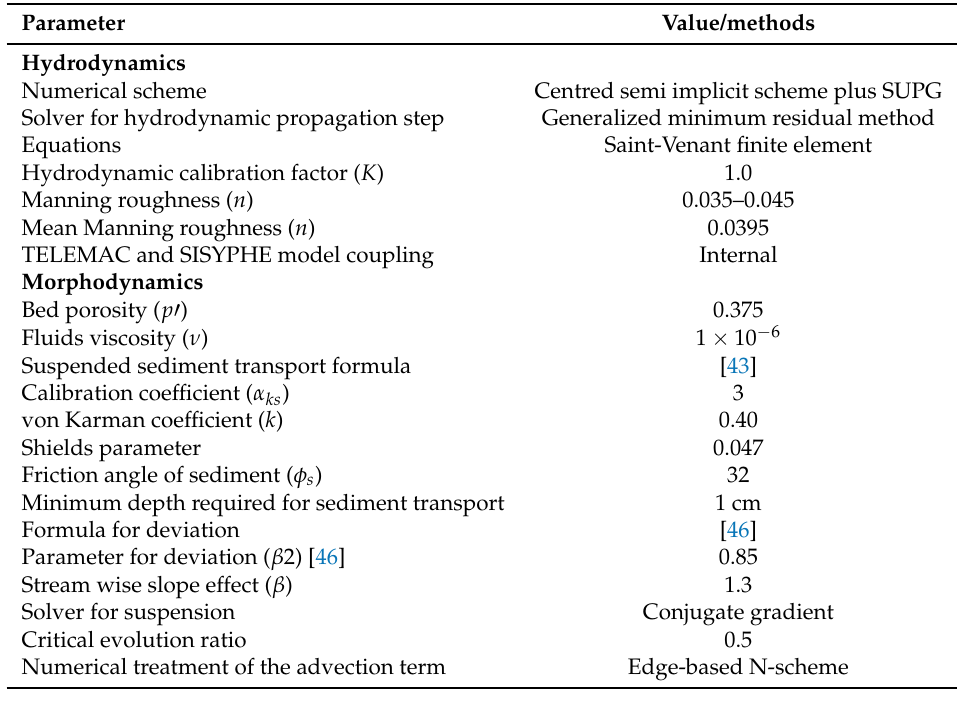
Table 4. Formulae and value of different hydro-morphodynamic parameters (stated in Equations (10)–(16)) used in the calibration process.